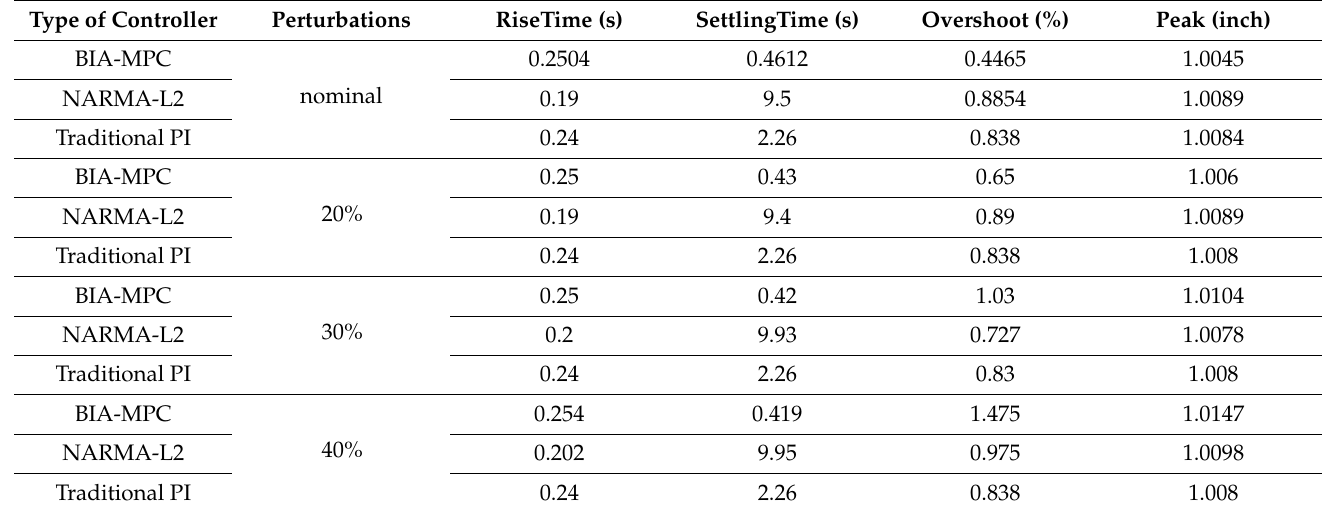
Table 2. Evaluation of Controllers Based on System Parameter Perturbation.